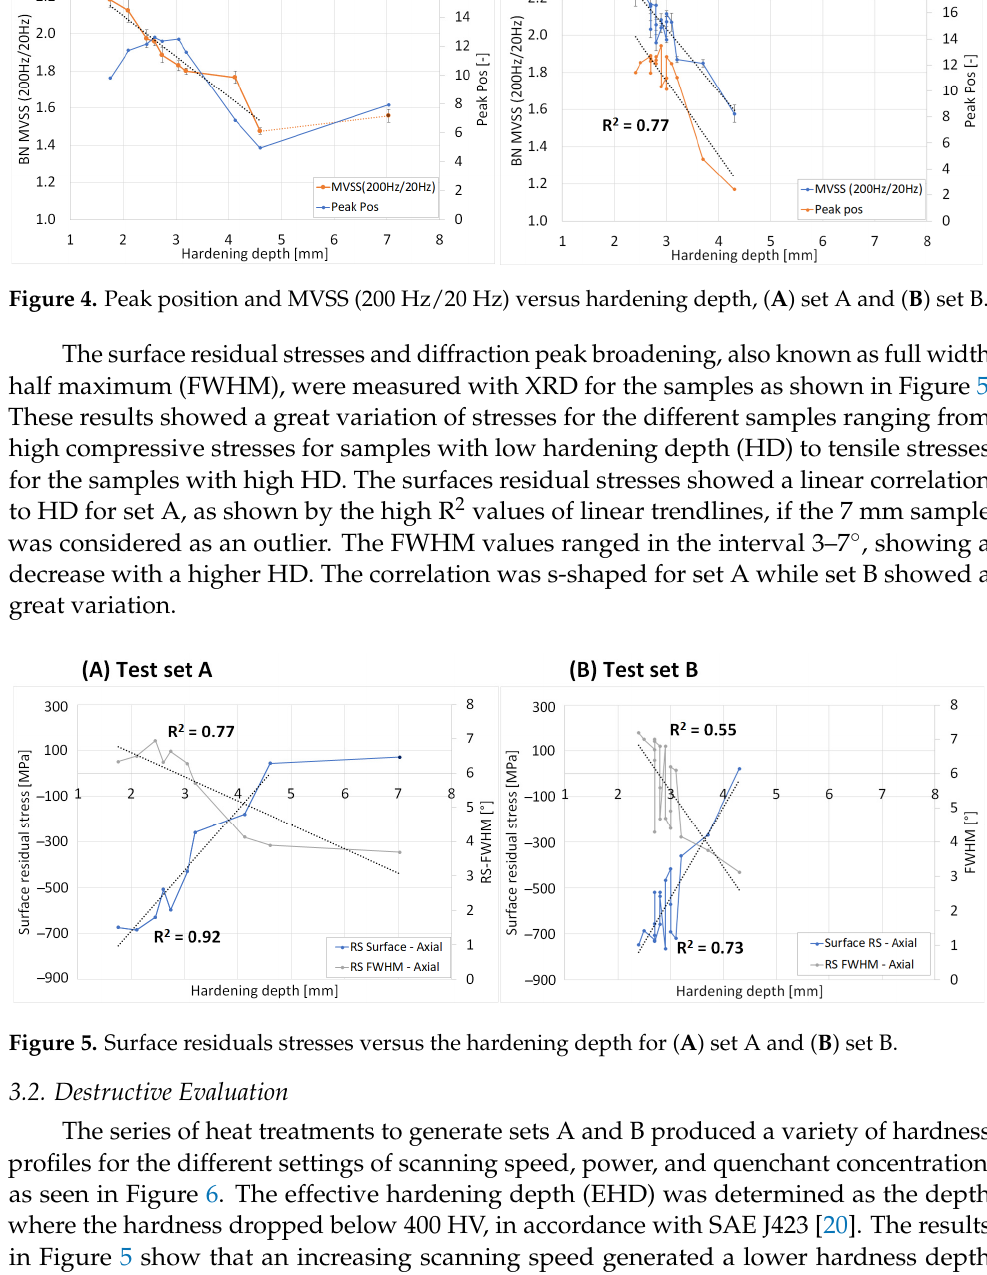
Figure 3. Barkhausen noise RMS and FWHM versus the hardening depth, ( A ) set A and ( B ) set B.